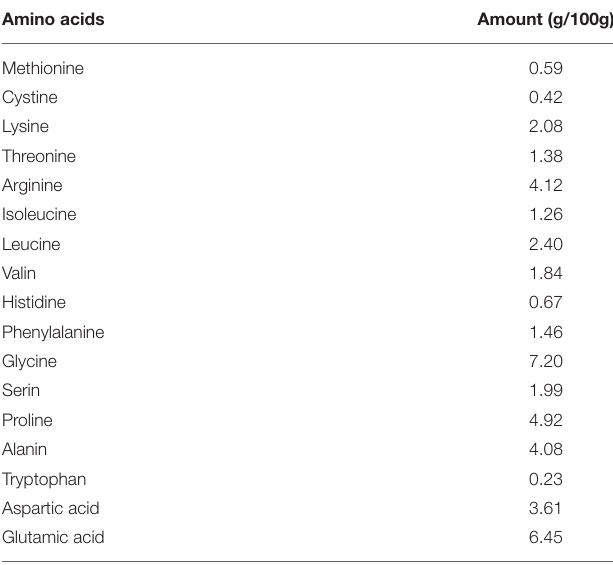
TABLE 3 | The amino acid compositions of the Agro-Matic protein concentrate. Amino acids